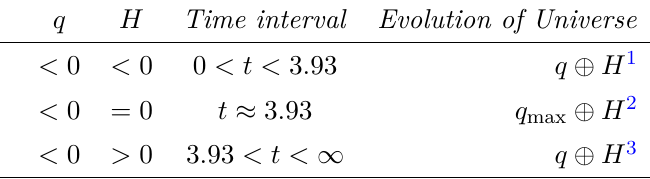
Table 2. Evolution of the universe for n = 2 . 15 , α = − 10 , β = − 4 . 7 and γ = 1 . 5